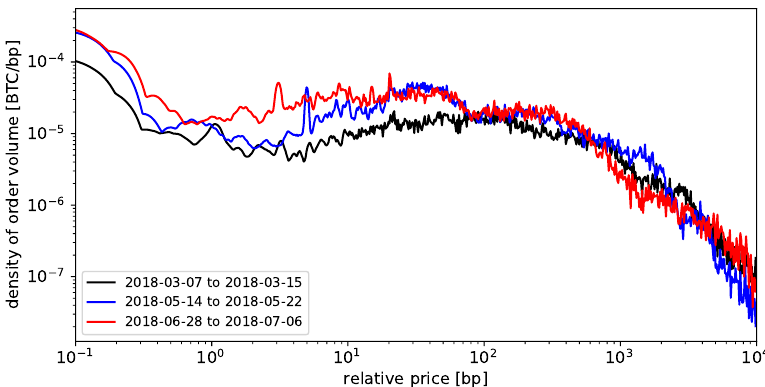
Figure 4. Time-averaged limit order depth in dependence of price. The plots show the time-averaged ( t ) (or q b ( t ) ) as a function of relative price for different subperiods of total limit order volume q a i i the